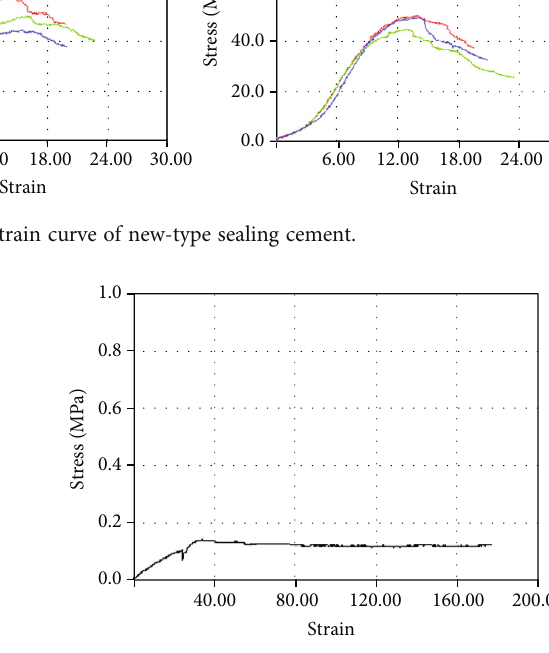
Figure 21: Uniaxial compressive stress-strain curve of foamed